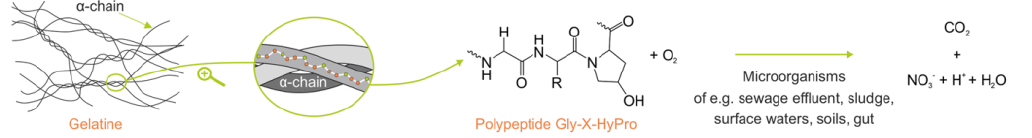
Figure 11. Degradation of gelatin blends and products due to microbial aging visualized by Melanie Baumgartner et al. in their work “Resilient yet entirely degradable gelatin-based biogels for soft robots and electronics” published in Nature Materials, 19(10), page 1102–1109 [44]. Mass Change of Samples after Biodegradation